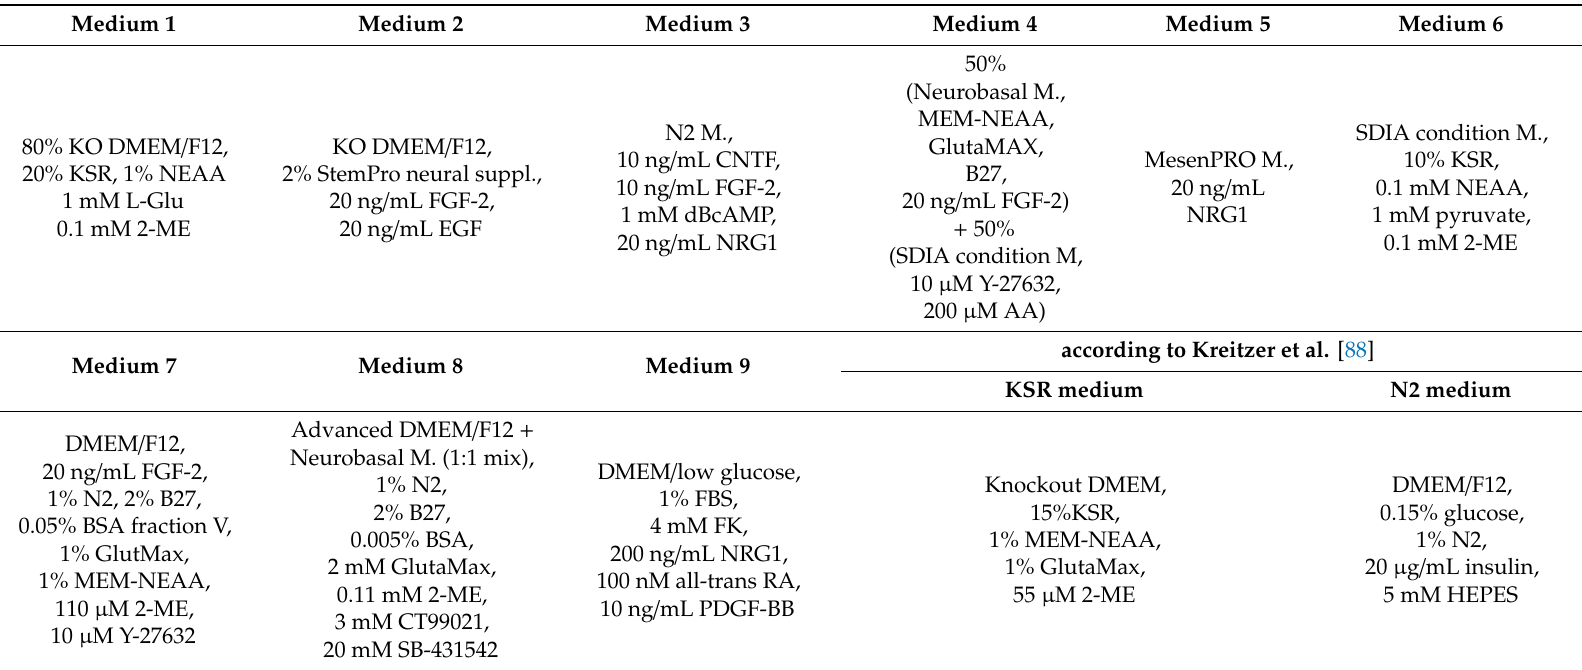
Table 1. Components of the various media used in the selected di ff erentiation protocols [85–90]. Many have similar base media, e.g., knockout (KO) DMEM / F12, as well as components routinely found in neuronal di ff erentiation cultures such as N2 and B27. GlutaMax is a more stable form of L-glutamine. The addition and concentration of additional growth factors varies substantially between